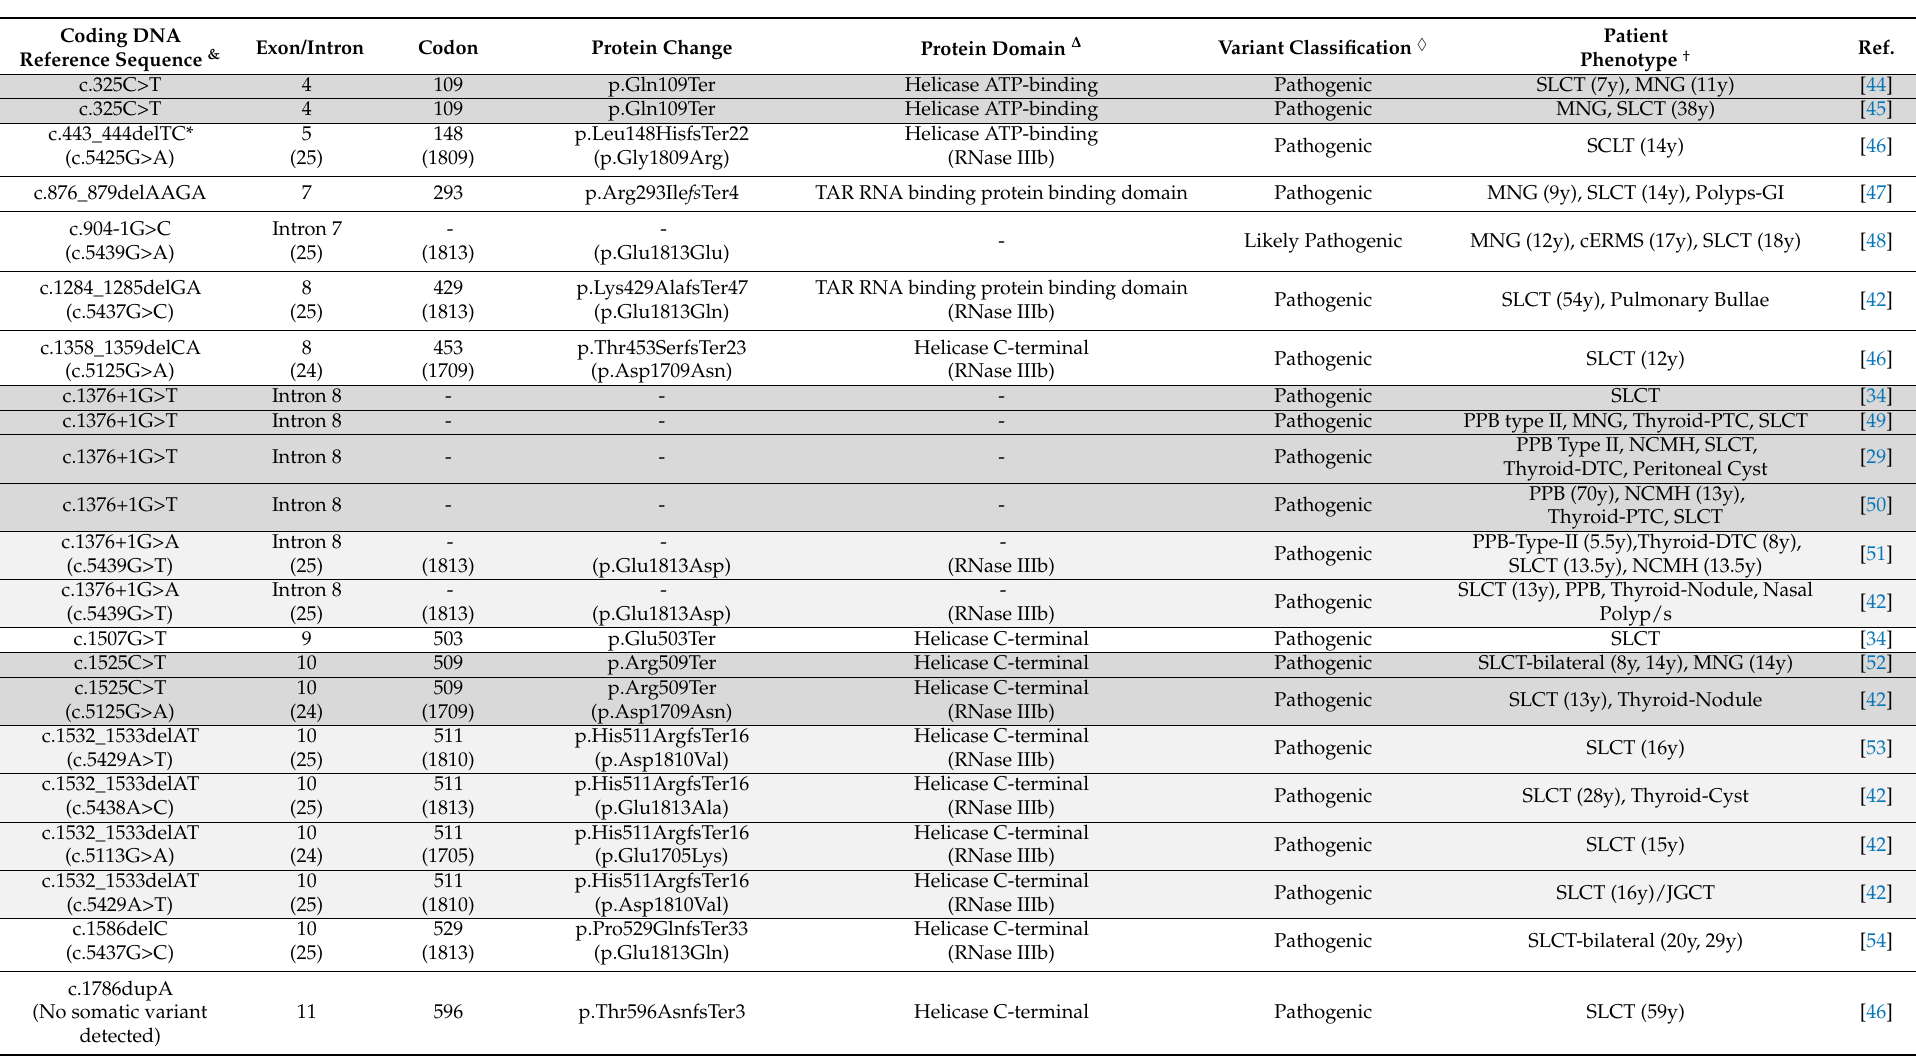
Table 1. Spectrum of DICER1 pathogenic variants reported in ovarian SLCT. If described in the corresponding case report, the concomitant somatic mutation is reported in bracket below the germline